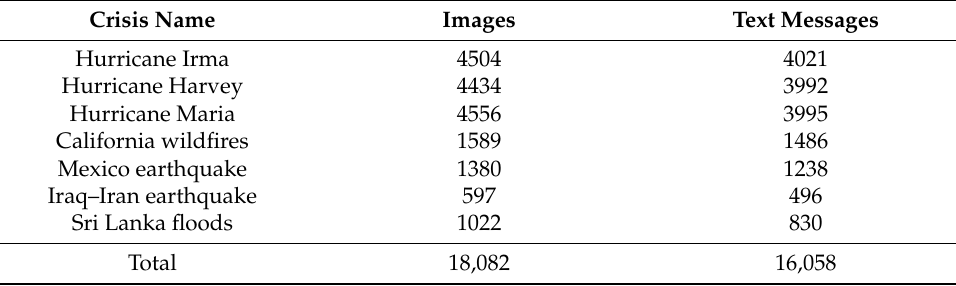
Table 1. The number of images and text messages in the